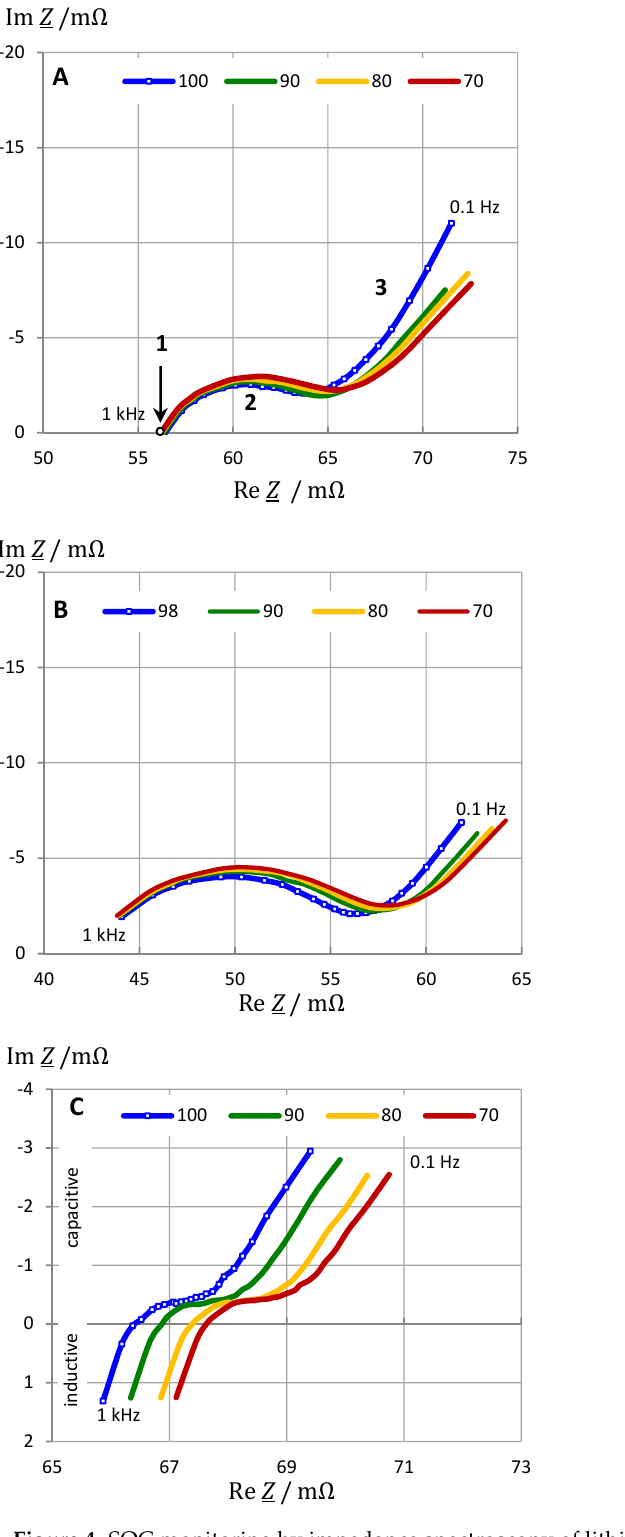
Figure 4. SOC monitoring by impedance spectroscopy of lithium iron phosphate (LFP) batteries at rest: ( A ) VoltSolar (1.5 Ah), ( B ) Sony (1.1 Ah), ( C ) LithiumWerks (2.6 Ah). Pseudocapacitance C ( ω ) according to Equation (4), where the electrolyte resistance R S = R (333 Hz) was subtracted from the real parts of impedance. Frequency range 0.1 Hz to 1 kHz. Regions: 1 Electrolyte resistance, 2 Charge transfer, 3 mass transport.